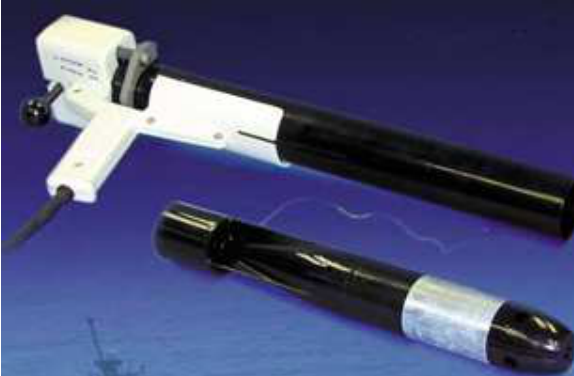
Figure 4. Expendable bathythermograph system.